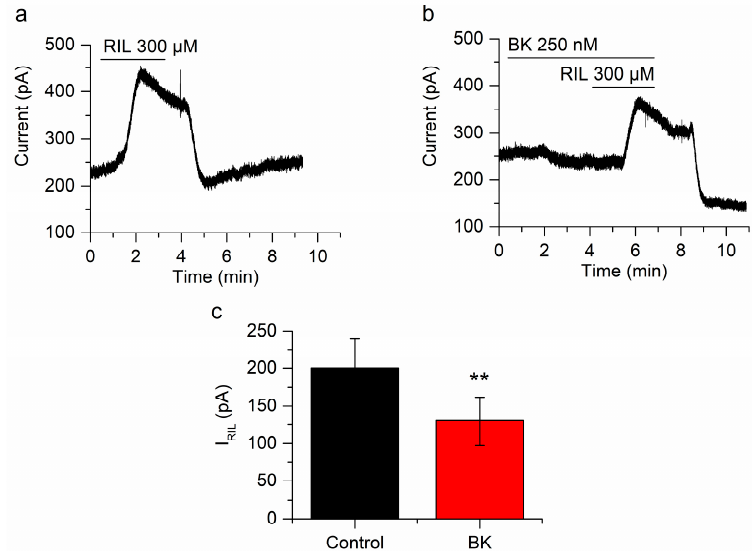
Figure 2. Bradykinin inhibits I RIL . ( a ) Outward current induced by the application of riluzole (RIL) (300 µ M) in mSCG neurons fixed at − 30 mV (I RIL ). ( b ) Both, the current at − 30 mV and I RIL are reduced in the presence of BK (250 nM). ( c ) The di ff erence between I RIL control (200.2 ± 39.3 pA, n = 7, black bar) and I RIL in the presence of bradykinin (129.8 ± 32.24 pA, n = 7, red bar) was clear and significant ( p